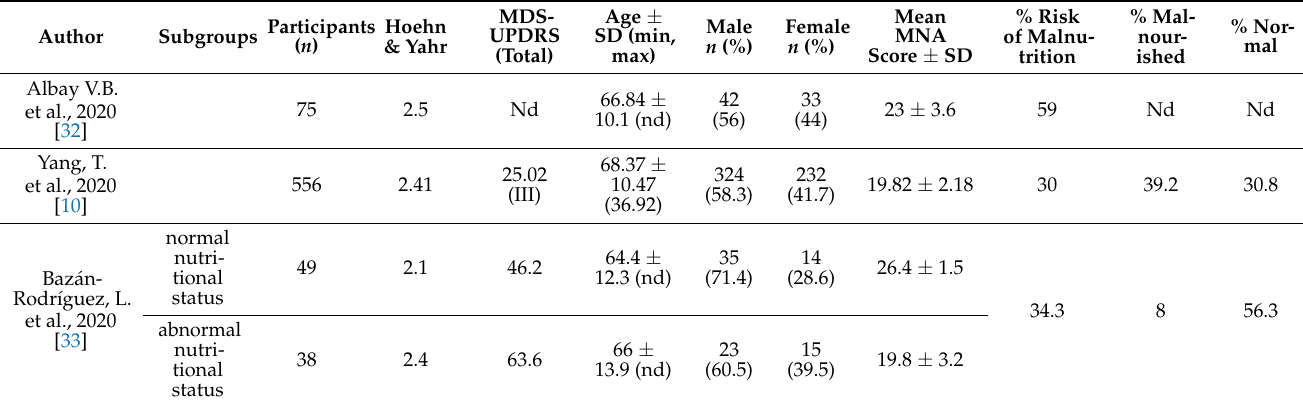
Table 9. MNA questionnaire